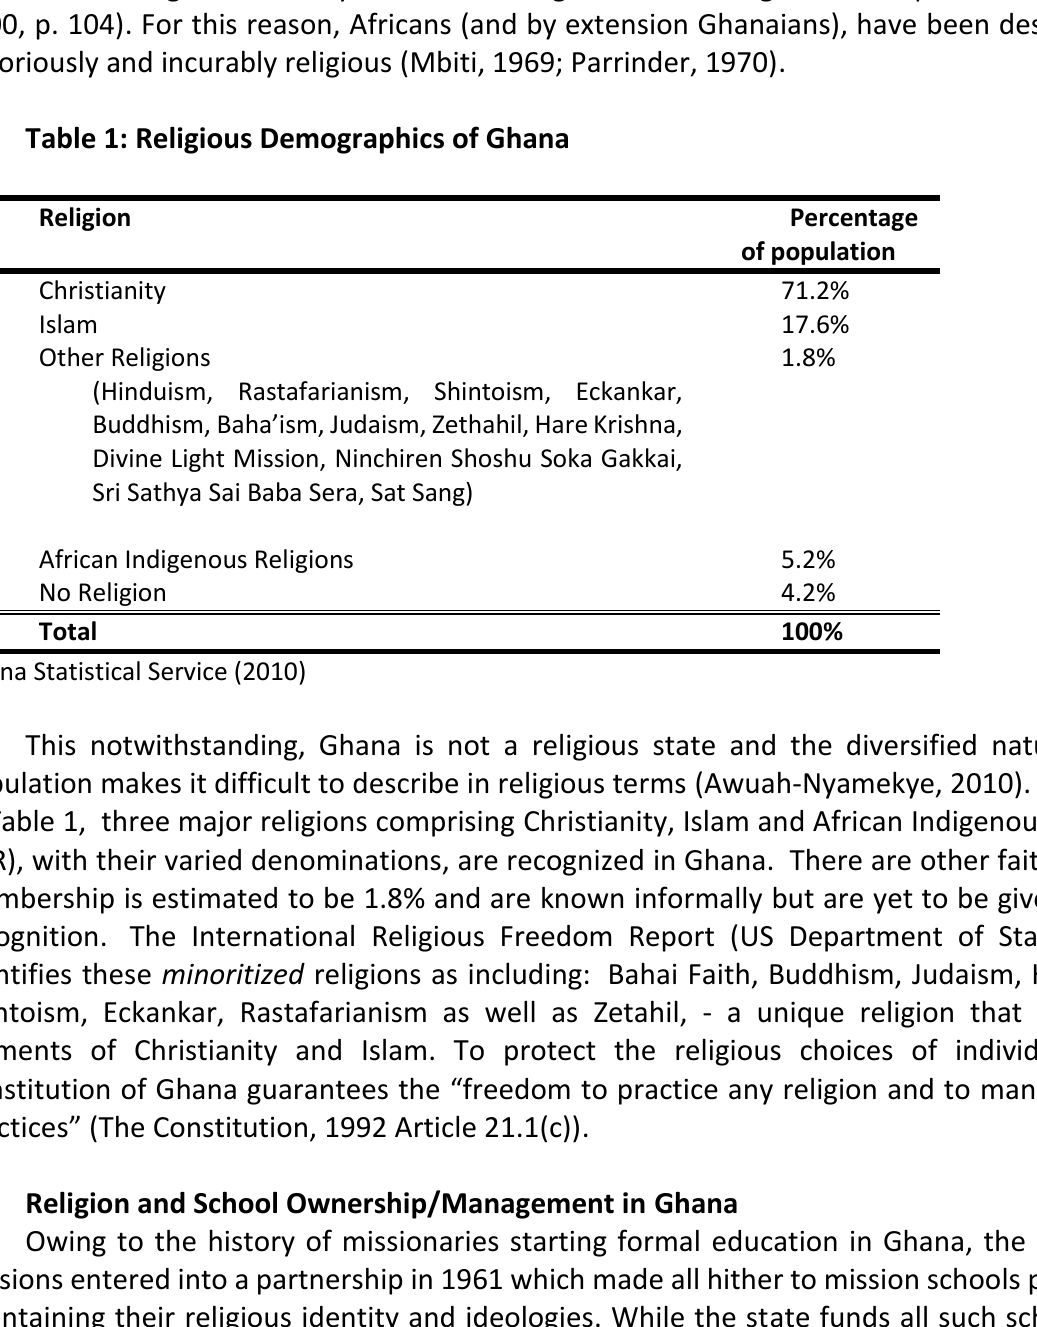
Table 1: Religious Demographics of Ghana